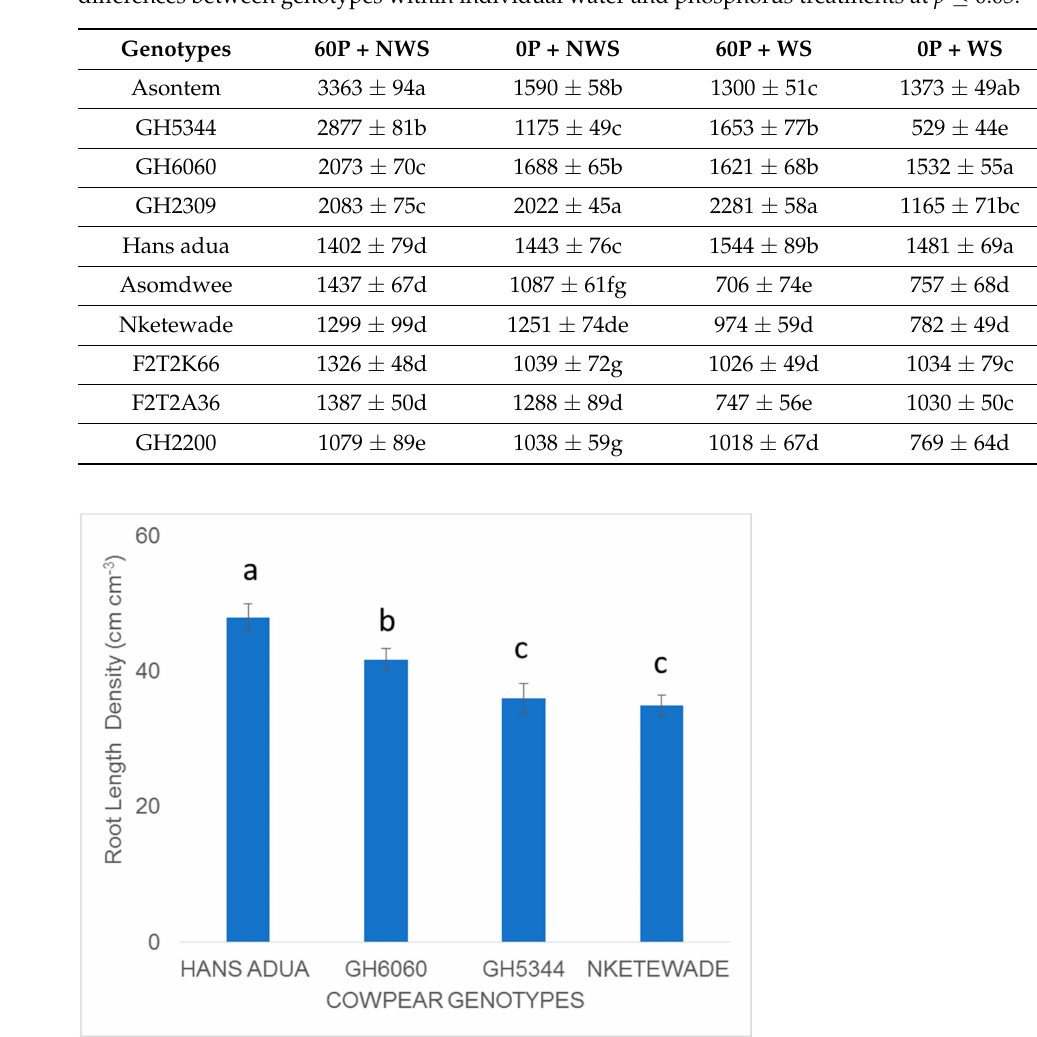
Table 7. Average grain yield (kg ha − 1 ) of all the genotypes at maturity for the years 2017 and 2018. Values represent ± S.E. of the mean ( n = 3). Values showing the same letters indicate no significant differences between genotypes within individual water and phosphorus treatments at p ≤ 0.05.